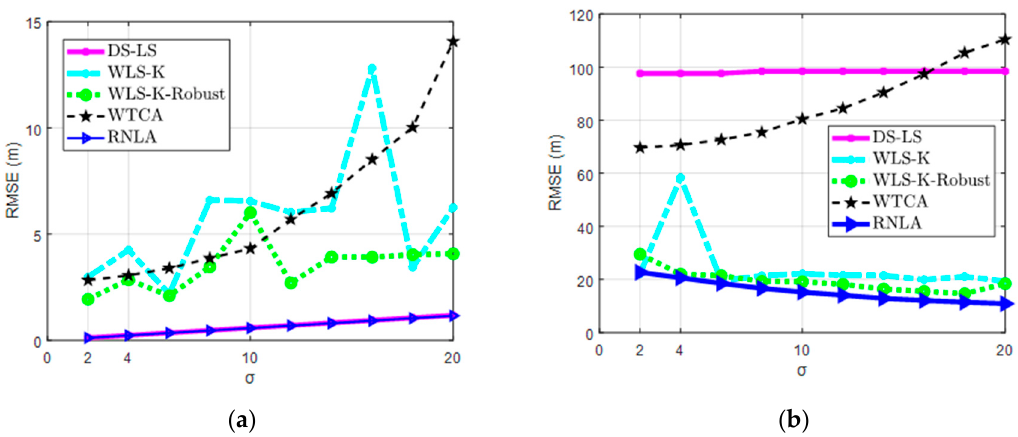
Figure 5. RMSE under variable σ : ( a ) Localization performance without outlier measurements, and ( b ) Localization performance with outlier measurements.